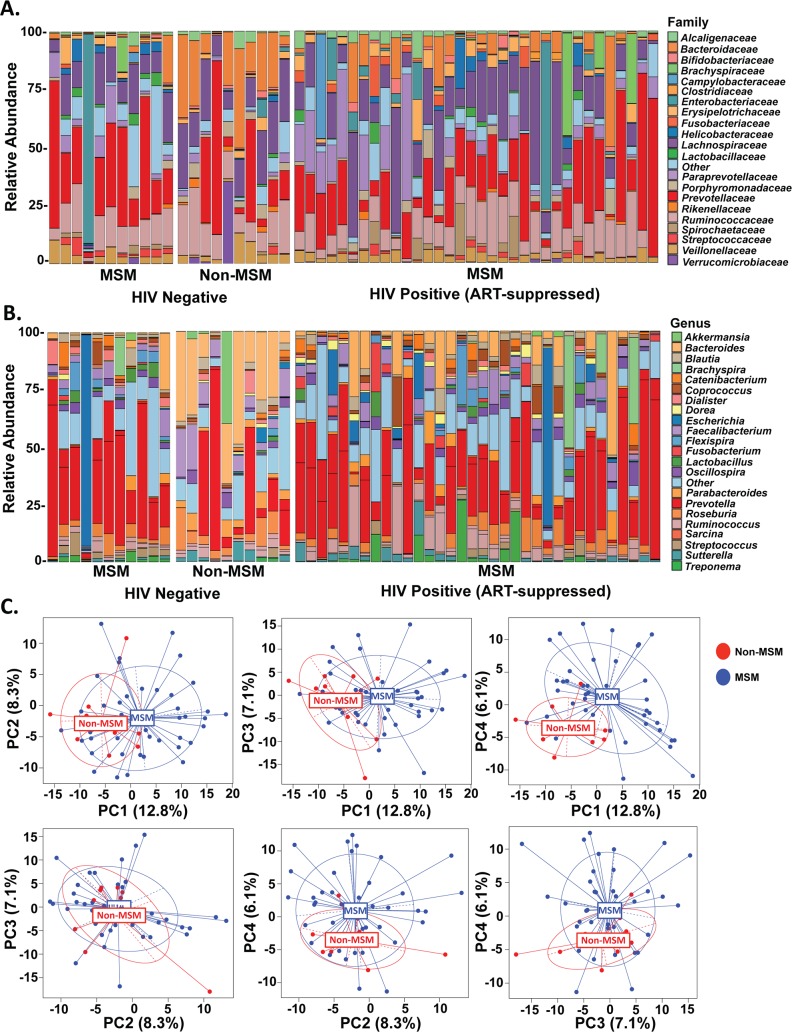
Microbial composition of colorectal biopsies associates with sexual orientation in men.Microbial composition of colorectal biopsies from HIV-infected, ART-suppressed and uninfected men as measured by 16S rRNA sequencing and categorized as MSM or non-MSM. A.) Relative abundances of the 21 most abundant families with the remaining taxa categorized as “Other”. B.) Relative abundance of the 22 most abundant genera with the remaining taxa categorized as “Other”. C.) Principal component plots visualizing differences in microbial composition between MSM and non-MSM individuals following adjustment for age, race, sex, and HIV-status.